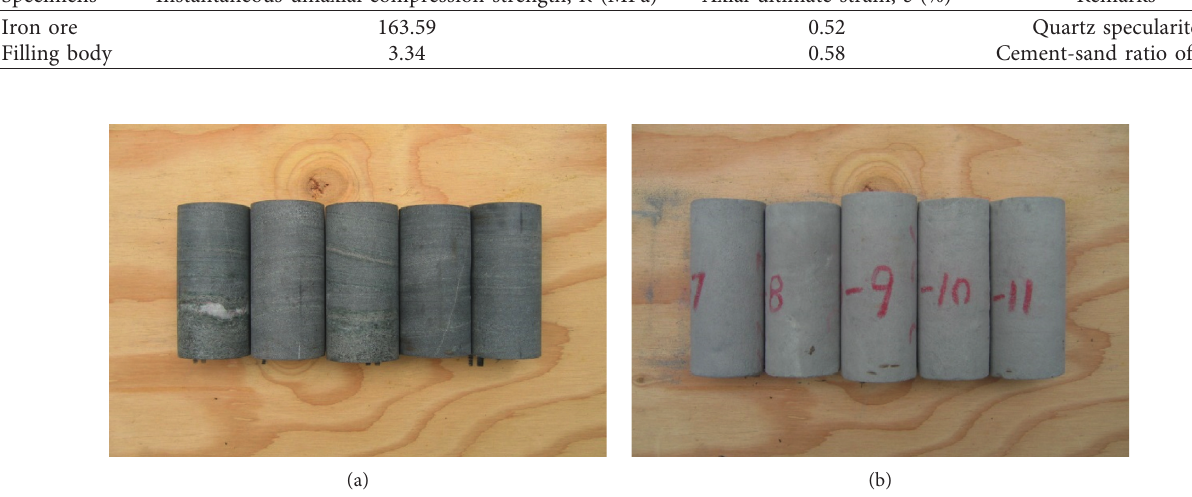
Figure 2: Specimens of creep experiment. (a) Iron ore specimens. (b) Filling body specimens.